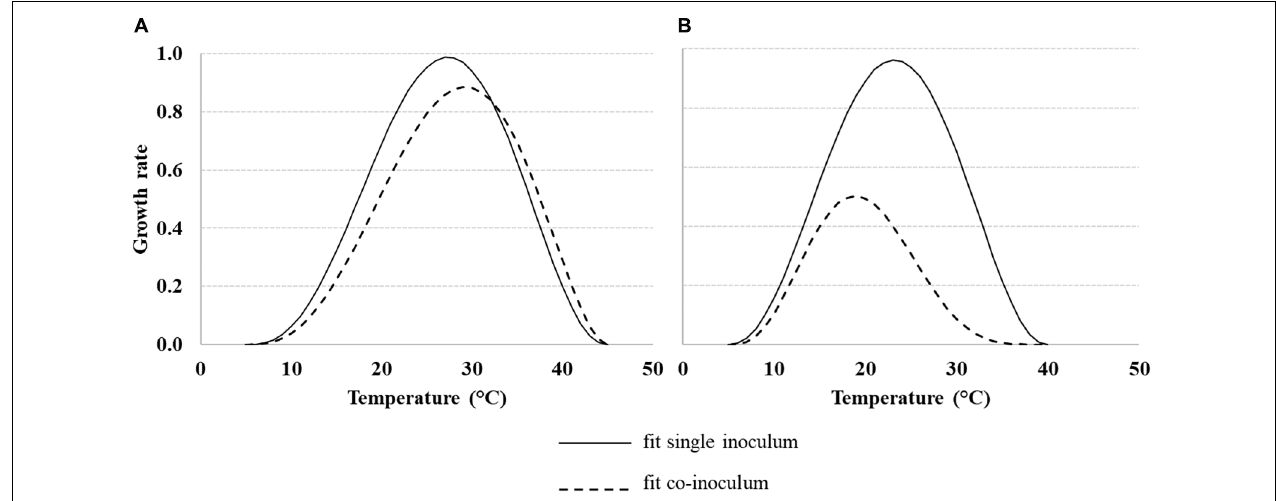
FIGURE 4 | Dynamic of the growth rate of Aspergillus flavus ( Af ) (A) and Fusarium verticillioides ( Fv ) (B) , under different temperature regimes (10–40 ◦ C), grown alone or together. Data were fitted by a non-liner function (Eq. 1, Table 2 for equation parameters) both for fungi grown alone (solid line) and together (dotted line).